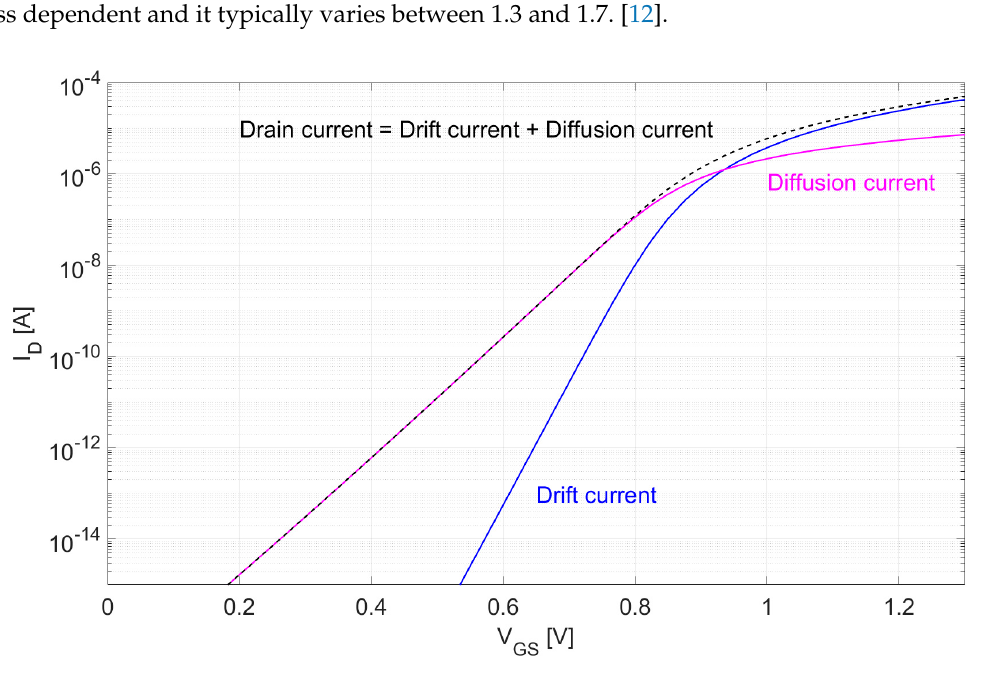
Figure 2. Drain current with the drift and diffusion contribution. The drift current dominates in strong inversion, diffusion current in weak inversion.